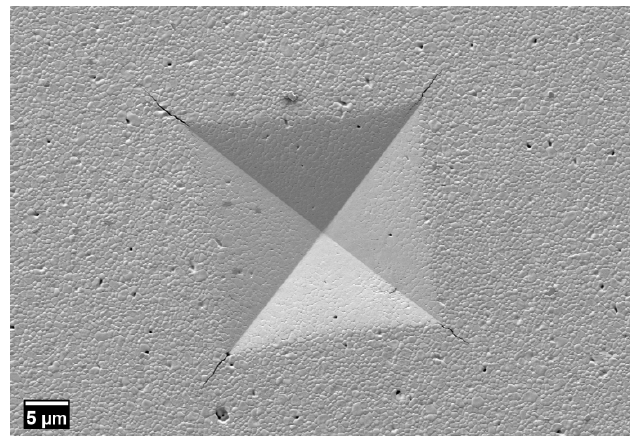
Figure 7. Indent at 1000× magnification, for reference.